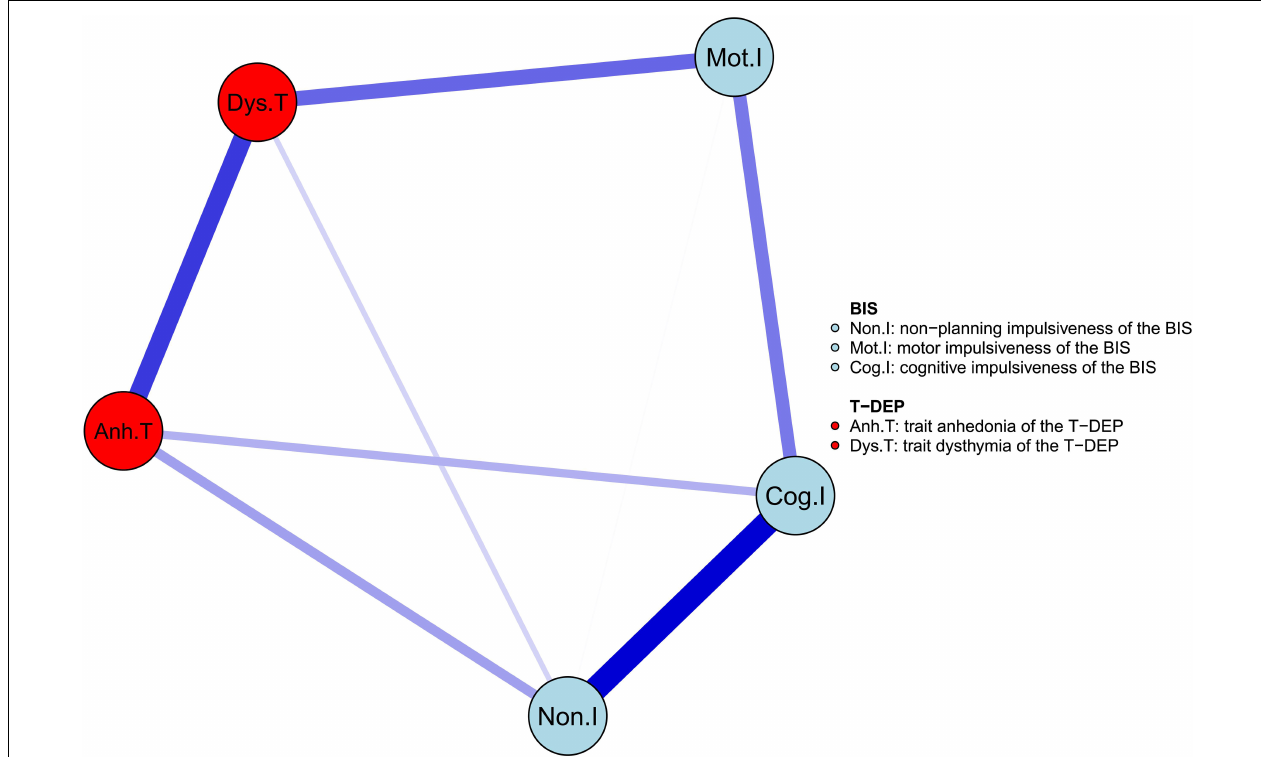
FIGURE 2 | The network structure of trait depression and impulsiveness in the youth. The edge weight values are listed in Supplementary Table 2 .